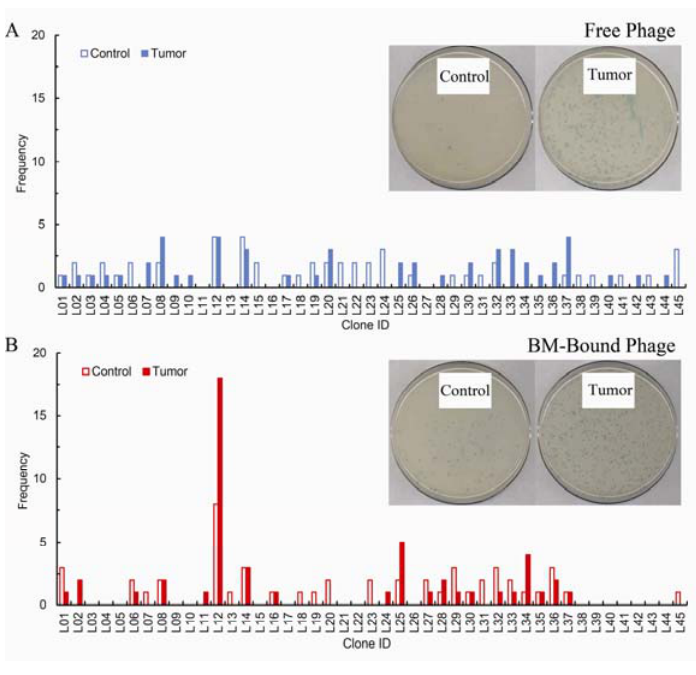
Figure 3. Frequency of sequenced peptide ligands selected either by panning with free phage (A) or by panning using bone marrow-bound phage (B). After three rounds of in vivo selection, fifty phage clones homing to tumors and to Matrigel controls from each protocol were randomly chosen for sequencing. Frequency refers to the number of times each phage was isolated out of the total number of phage sequenced. In vivo selection with free phage produces no apparent enrichment of particular clones. By stark contrast, three rounds of in vivo functional selection, using BM cells to direct the phage pool to the tumor site, are sufficient to identify a dominant amino acid sequence. The inserts in both panels represent typical plates from which phage clones were selected and processed for